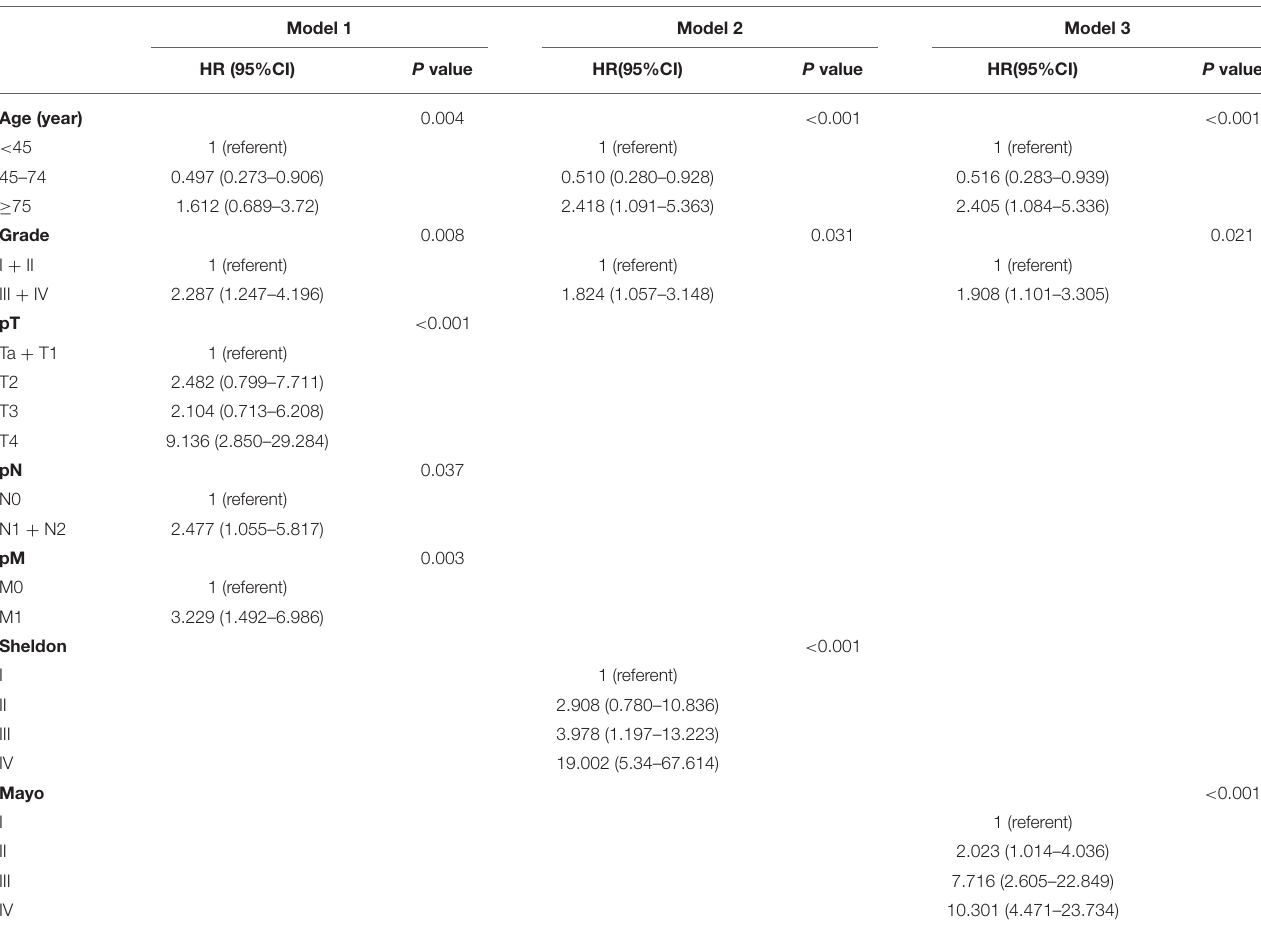
TABLE 2 | Multivariate Cox analyses for the prediction of cancer-specific survival with urachal